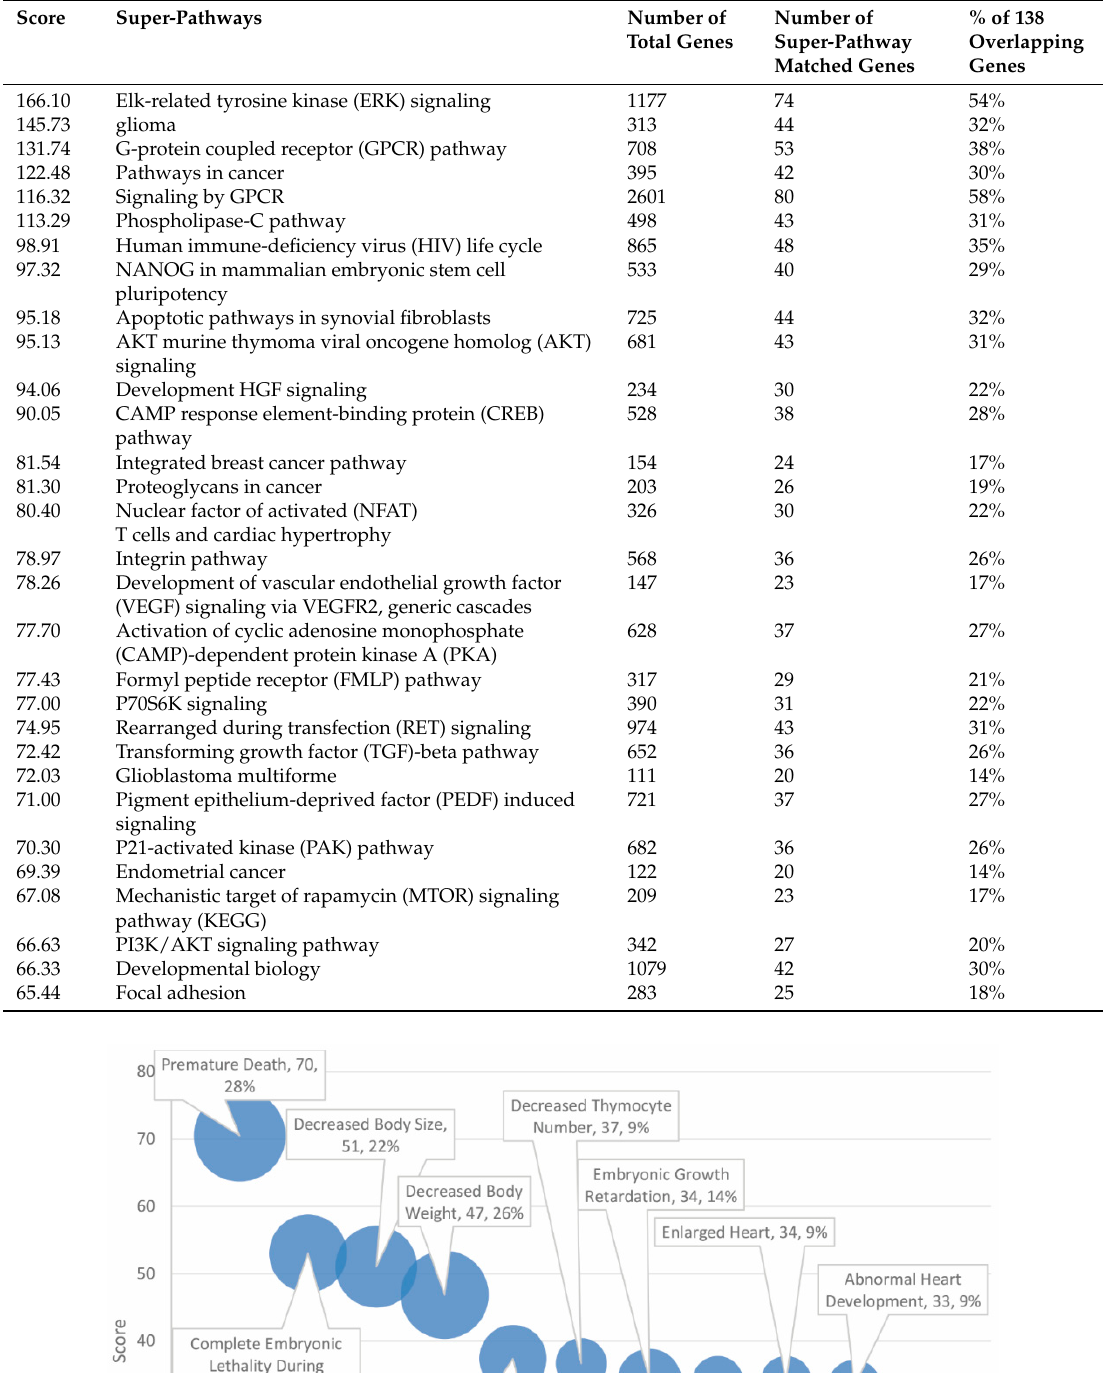
Table 2. Profiling of high scores in overlapping genes for autism and cancer-associated super-pathways.